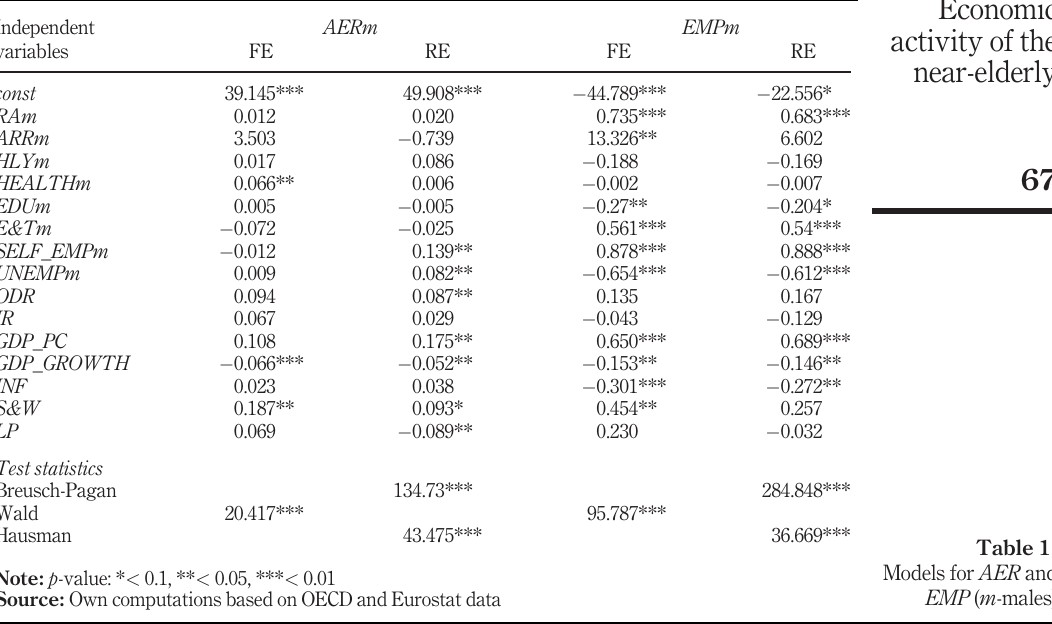
Table 1. Models for AER and